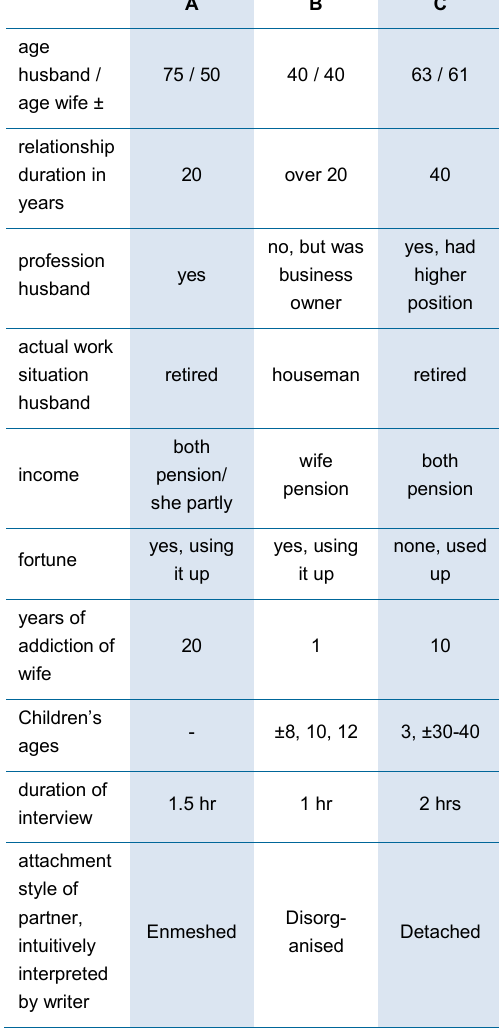
Table 4 Socio-demographics of husband/couple and duration of interview